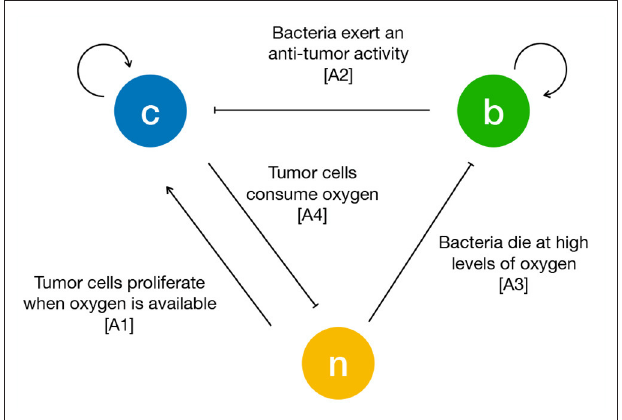
FIGURE 1 | Schematic of the interactions between tumor cells ( c ), bacteria ( b ) and oxygen ( n ). The arrows are drawn according to the biological hypotheses detailed in the main text.